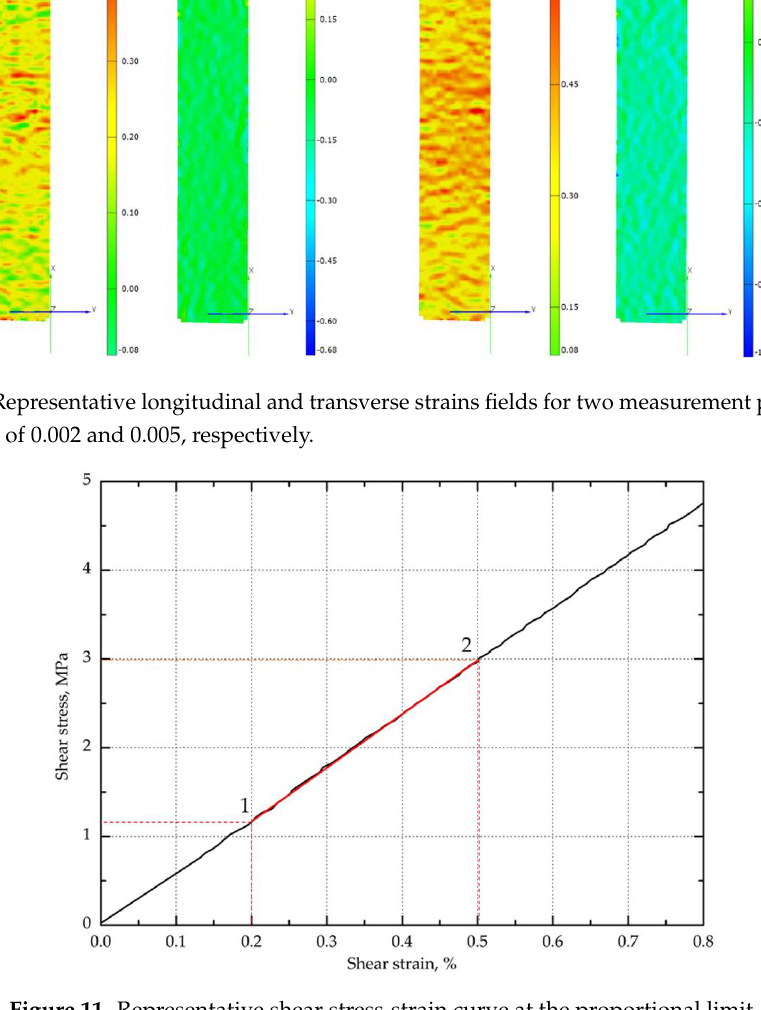
Figure 11. Representative shear stress-strain curve at the proportional limit.